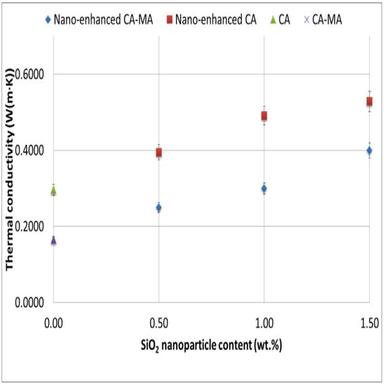
Thermal conductivity (W/m·K) as function of SiO2 nanoparticle content (wt.%).